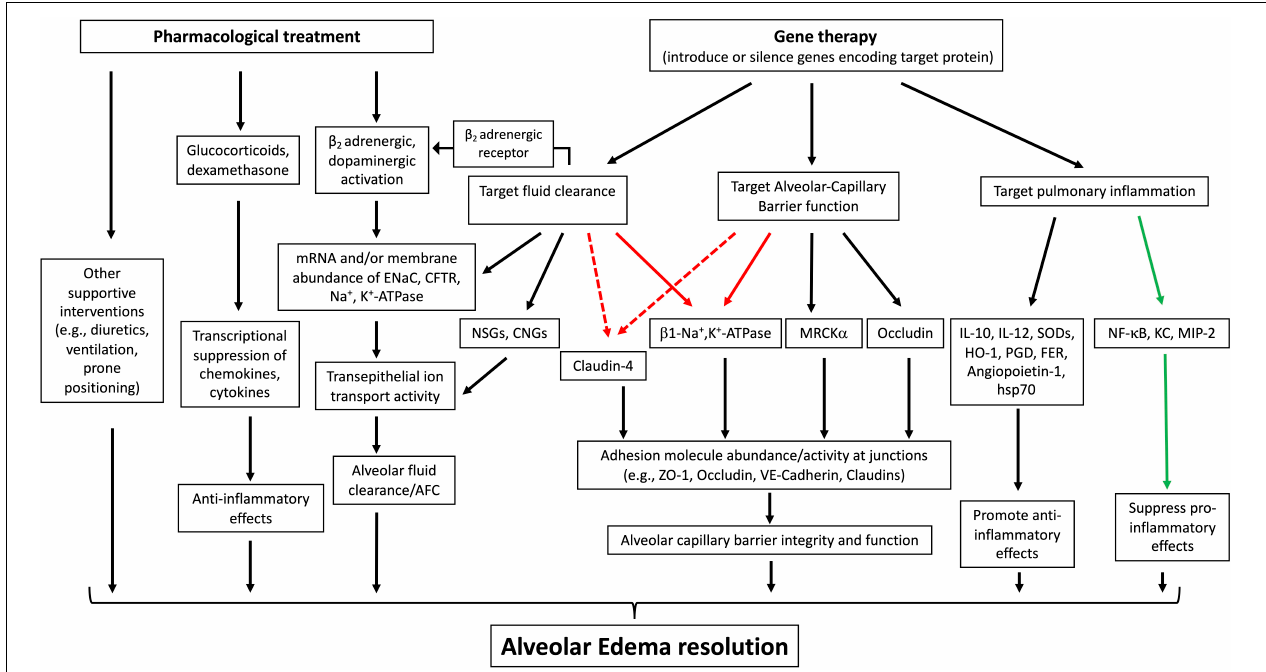
FIGURE 3 | Therapeutic approaches to treat acute lung injury (ALI)/ARDS. Pharmacological interventions primarily focus on enhancing fluid clearance through b2 adrenergic or dopaminergic activation, dampening inflammation with glucocorticoids, and use of supportive strategies, all of which have led to limited therapeutic effects. Gene therapies to overexpress or silence target genes have targeted alveolar fluid clearance, alveolar capillary barrier function, and pulmonary inflammation. The protein targets of gene therapy for ARDS/ALI have been validated in various animal or ex vivo organ models, indicating their therapeutic potential. Black solid arrow: increase, upregulate or target downstream effects; green solid arrow: decrease or inhibit target proteins; red solid arrow: has been validated in various animal models to have a dual role in both upregulating fluid clearance and lung barrier function; red dotted arrow: has the potential for dually upregulating fluid clearance and lung barrier integrity. ENaC, epithelial sodium channel; CFTR, cystic fibrosis transmembrane conductance regulator; NSGs, non-selective cation channels; CNGs, cyclic nucleotide-gated channels; MRCKa, CDC42 binding protein kinase alpha; ZO-1, zonula occludens-1; VE-cadherin, vascular endothelial-cadherin; HSP-70, heat shock protein 70; HO-1, heme oxygenase-1; KC, murine chemokine CXCL1; MIP2, murine chemokine CXCL2; PGDsyn, prostaglandin D